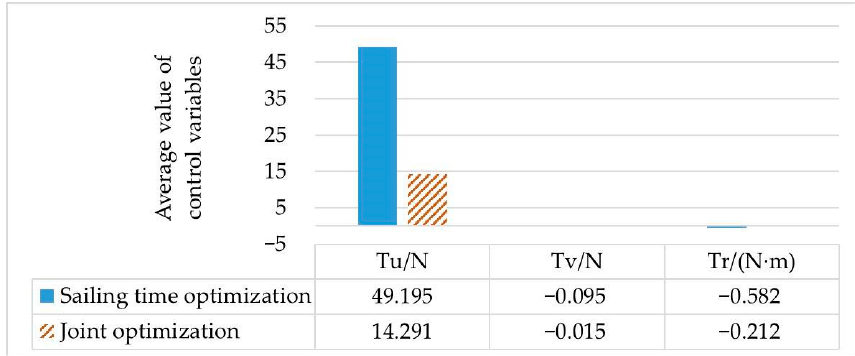
Figure 5. Comparison diagram of control variables in scenario 1 and scenario 3.